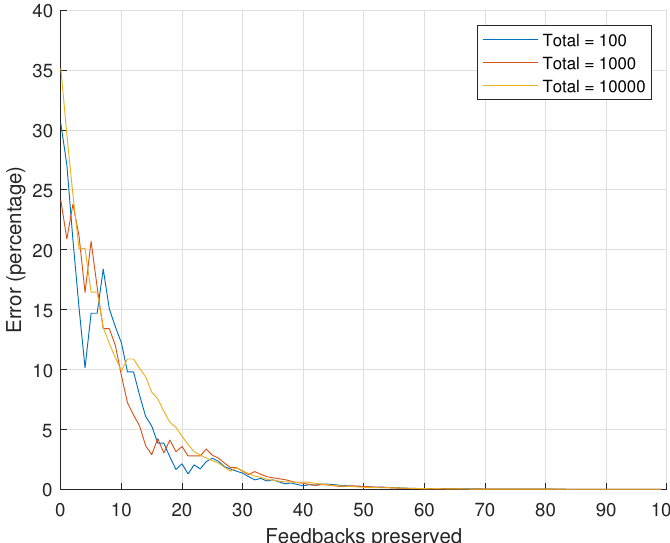
Figure 7. Error percentage for varying total number of feedbacks.